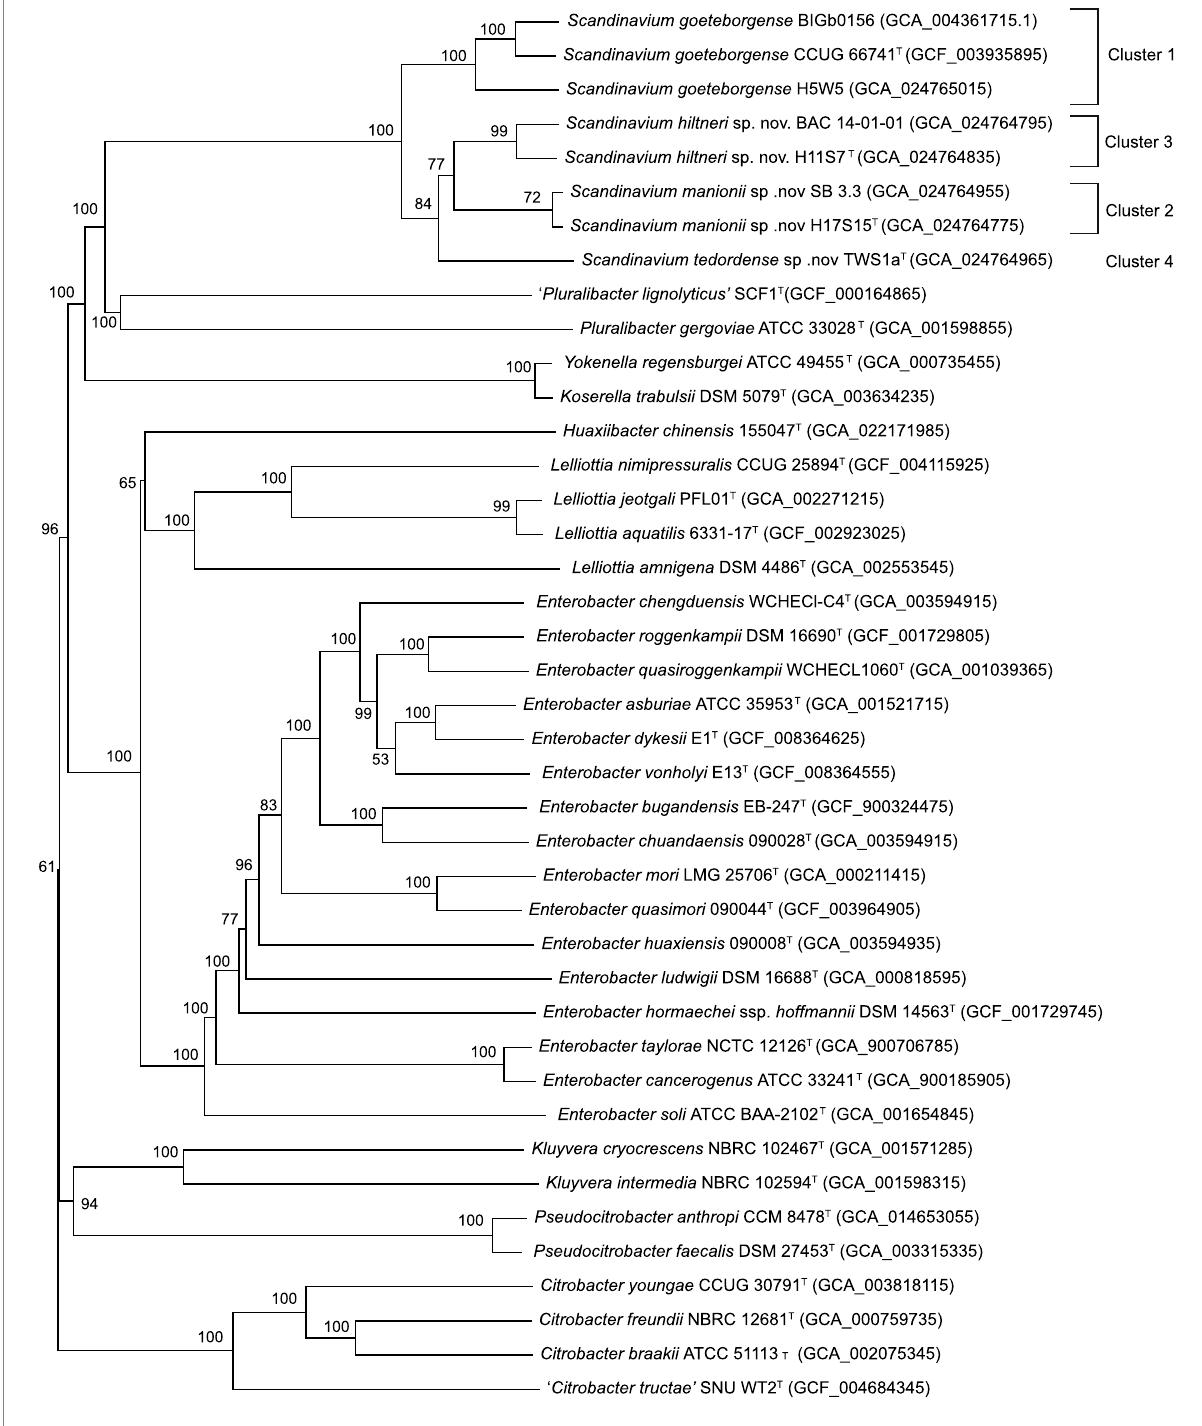
FIGURE 2 Phylogenomic tree for the genus Scandinavium including the three proposed novel species, Scandinavium hiltneri sp. nov. , Scandinavium manionii sp. nov. and Scandinavium tedordense sp. nov., and close phylogenetic neighbours. 100 replicate GBDP pseudo-bootstrap support percentages are shown (> 50%). d 5 GBDP distance formula was used to scale branch lengths, and the tree was rooted at the midpoint. Type strains denoted via T